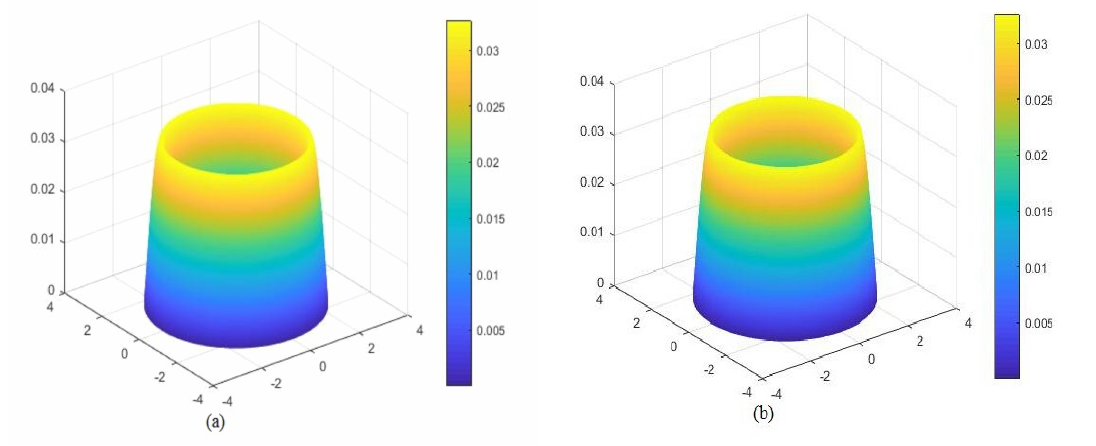
Figure 5. ( a ) The NBE solution u k at t = 0.8. ( b ) The analytical solution u k